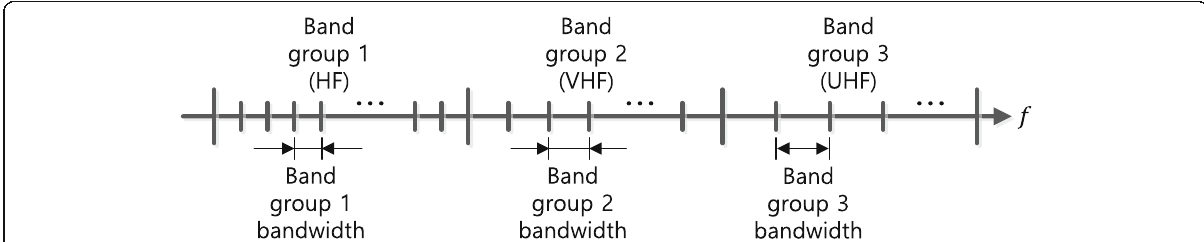
Fig. 2 Channel bandwidths for different band groups. A wireless communication system generally has a higher bandwidth and a higher data transmission rate as it goes to a higher